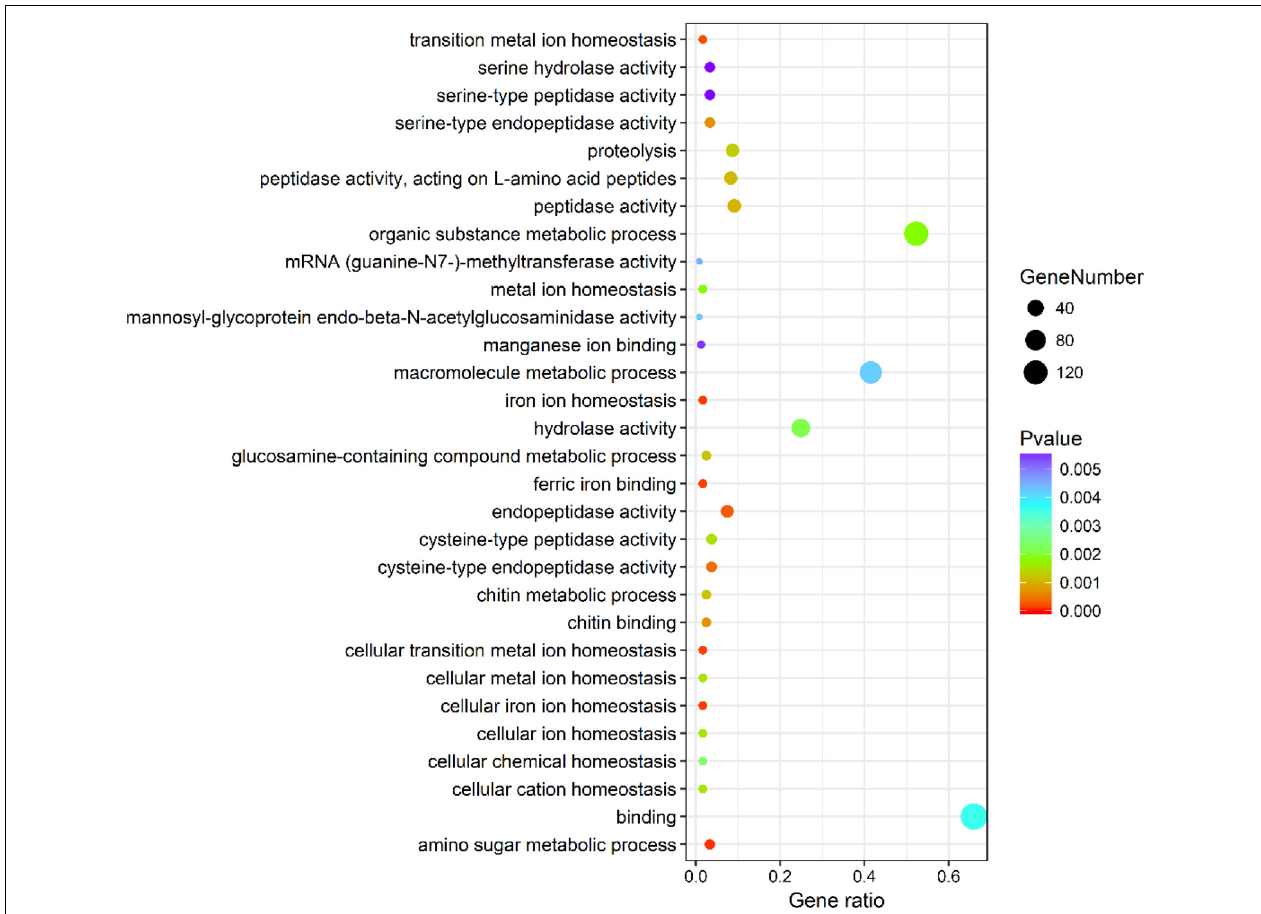
FIGURE 3 | Top 30 GO terms enrichment statistics between RL and YL at control